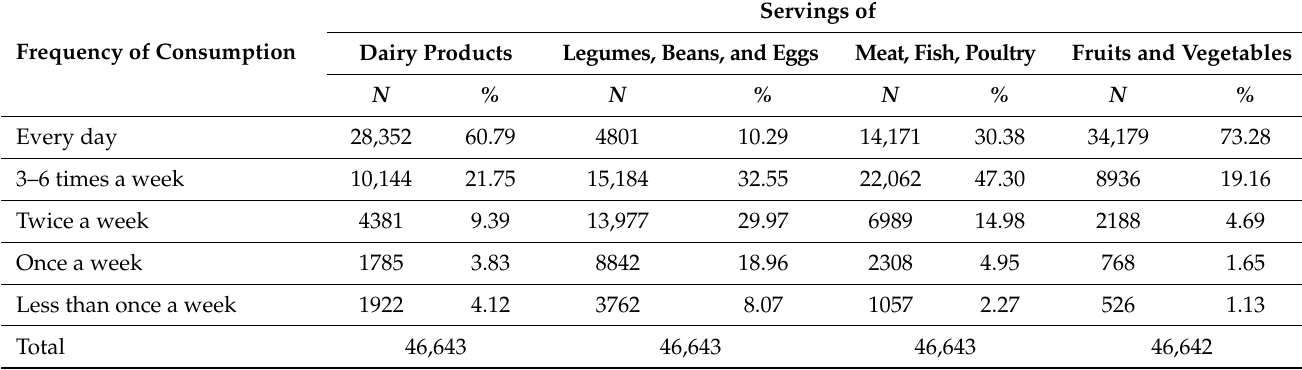
Table A1. Frequency (%) of food consumption from the four main groups with the corresponding number of